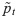
CC and MCC in the repeated PDG on the square lattice.The actual probability of cooperation, p˜t, is plotted against the fraction of cooperative neighbors in the previous round, fC. The error bars represent the mean ± standard deviation calculated on the basis of all players, tmax = 25 rounds, and 103 simulations. The circles represent the results not conditioned on at−1. The triangles and the squares represent the results conditioned on at−1 = C and at−1 = D, respectively. We set (A) β = 0.1 and A = 0.5, (B) β = 0.4 and A = 0.5, (C) β = 0.4 and A = 2.0, and (D) β = 0.4 and A = −1.0.